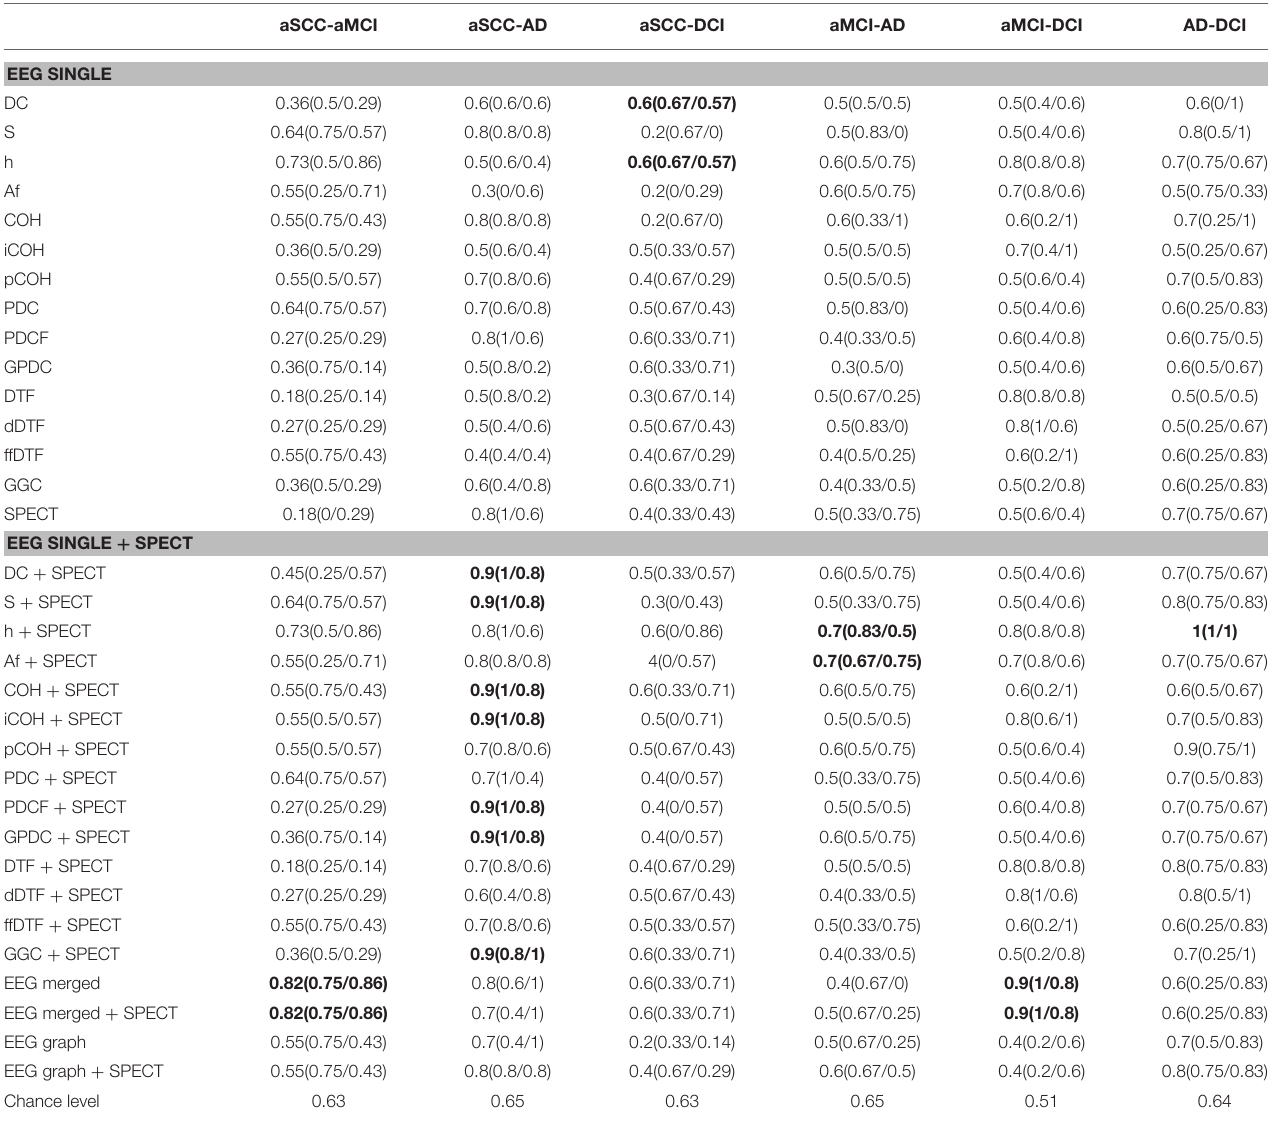
TABLE 3 | Sample comparison classification